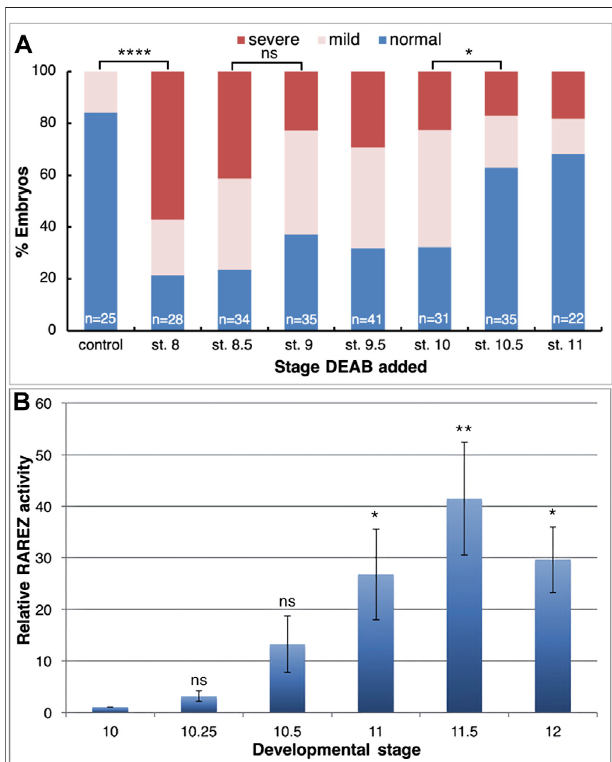
FIGURE 2 | RA function is required during the early gastrula stages for normal anterior head development. (A) Embryos were treated with DEAB starting at different developmental stages and analyzed for the effect on head development during tailbud stages (st. 32). (B) Untreated embryos were injected with the RA reporter plasmid, RAREZ. At different gastrula stages, groups of embryos (5) were collected and processed for chemiluminescent analysisoftheß-galactosidaseactivity. Sampleswerenormalizedtothest.10 sample. *, p < 0.05 **, p < 0.01; ****, p < 0.0001; ns, not signi fi